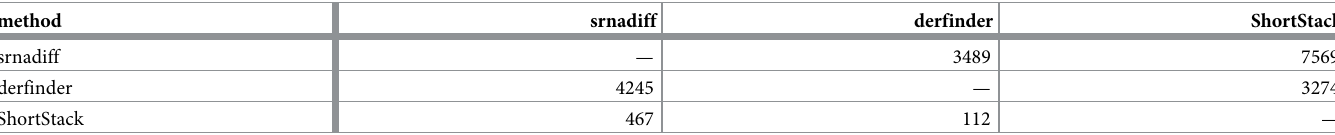
Table 2. Comparison of the results given by the srnadiff, derfinder, and ShortStack methods on the A. thaliana dataset. See Table 1 for the meaning of each